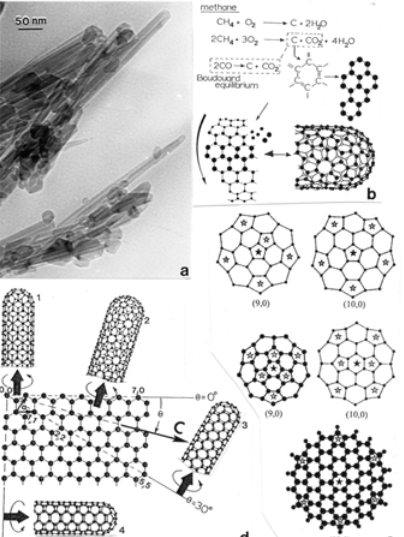
Figure 5: Nucleation growth and speciation of carbon nanotubes. (a) TEM image of aggregated MWCNTs and multiconcentric fullerenes collected above a natural gas kitchen burner by thermal precipitation [38]. (b) Carbon nanotube or fullerenic PM formation by methane combustion from hemispherical end caps. (c) Shows a few examples of end cap nuclei from Lair, et al. [42, 43]). (d) Shows single wall CNT conversions. 1 denotes zig-zag, 2 is chiral (0 < θ < 30º), 3 and 4 are armchair types. Large arrows are tube axes normal to C . (After Murr and Soto [46]).